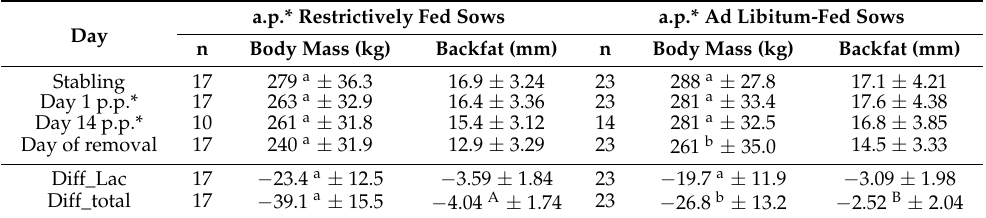
Table 6. Mean values of the sows’ body masses (kg) and backfat thicknesses (mm) in the feeding groups during lactation.